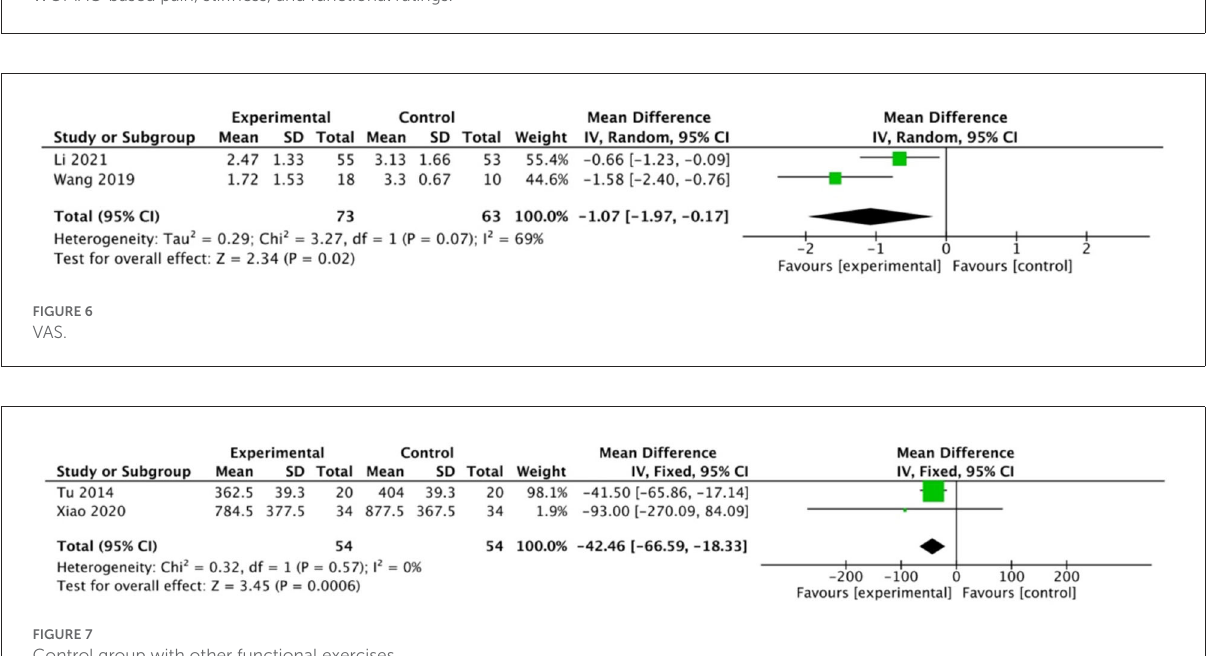
FIGURE7 Control group with other functional